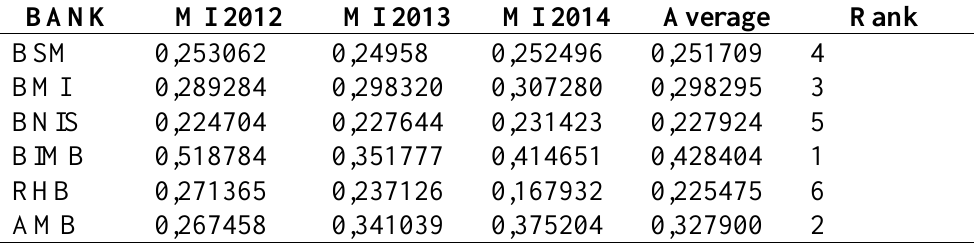
Table 11 Performance of Maqashid Syariah Index